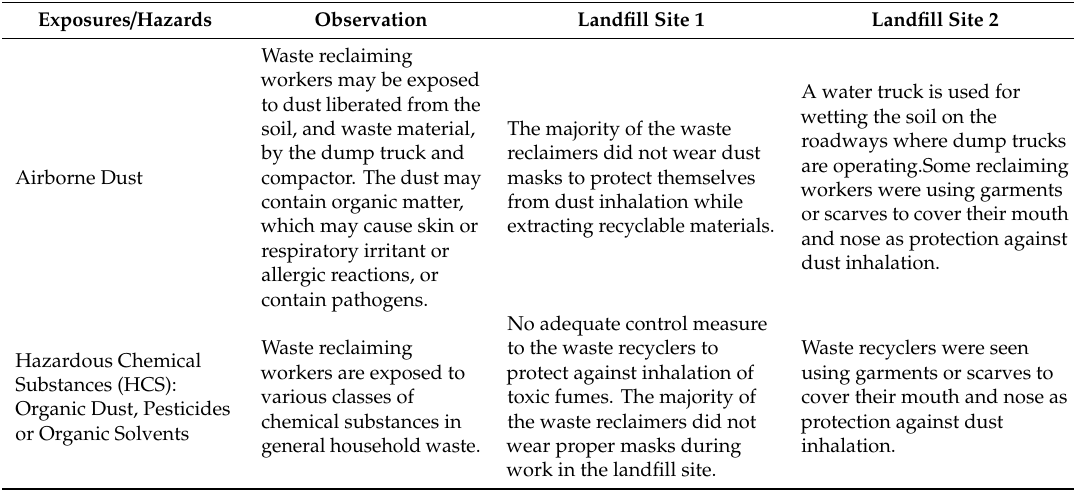
Table 2. Description of occupational exposures and hazards common on landfill sites, assessed using a health risk assessment process.